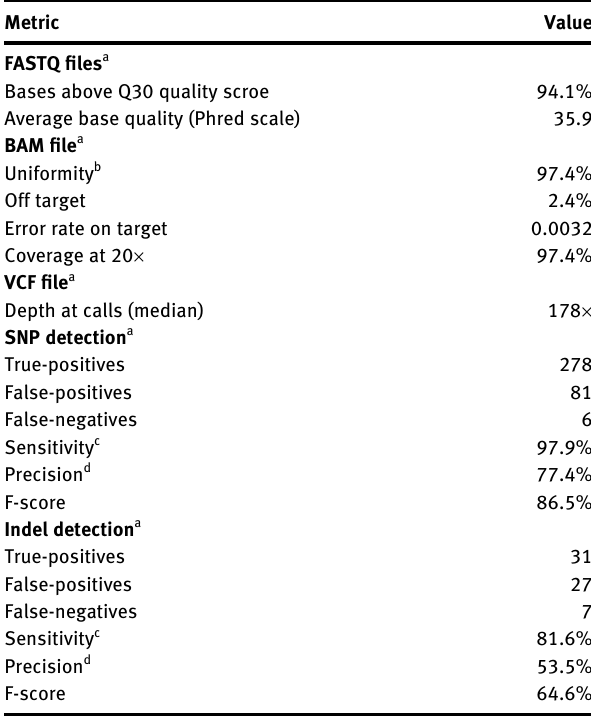
Table  : Result summary of European Molecular Genetics Quality Network (EMQN) pilot external quality assurance (EQA) scheme for next generation sequencing (NGS) (germline 